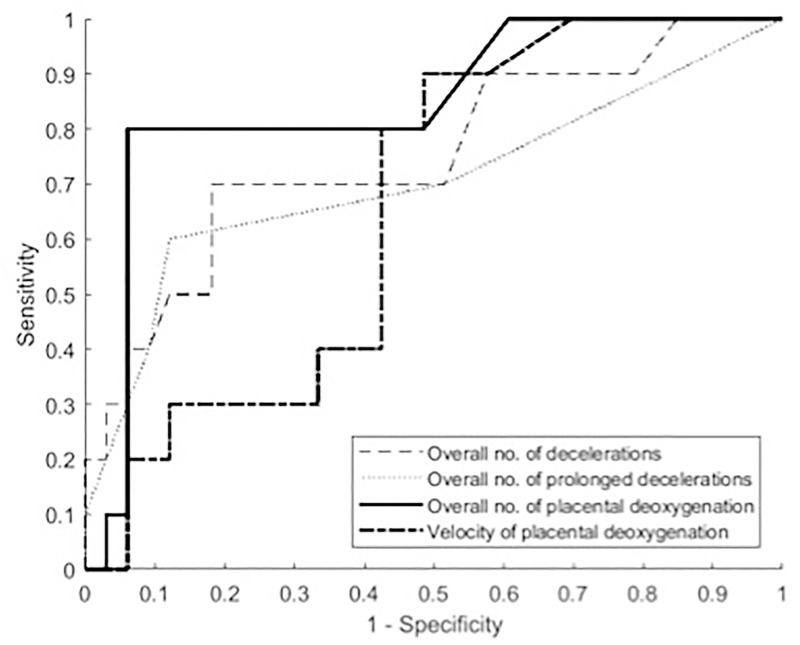
Comparison of receiver-operating characteristics (ROC) curves for CTG and NIRS parameters to predict pH ≤ 7.20.Overall no. of decelerations: AUC 0.75, 95% CI (0.57–0.94). Overall no. of prolonged decelerations: 0.71 (0.49–0.92). Overall no. of placental deoxygenation: 0.85 (0.70–0.99). Velocity of placental deoxygenation: 0.66 (0.49–0.83). AUC: area under the curve, CI: confidence interval.